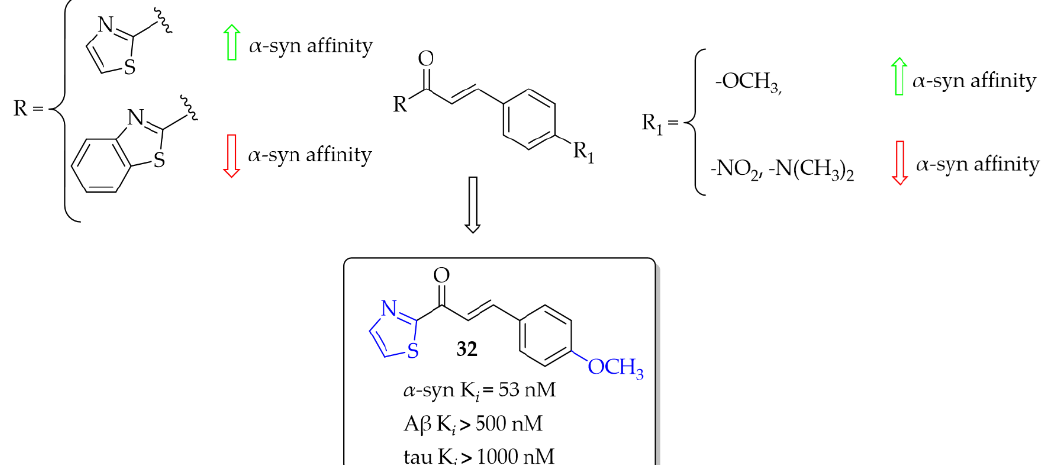
Figure 24. Chalcones with affinities for α -syn fibrils and the most active compound in the series [54]. Designing α -syn detection probes was also described by Kaide et al. [55]. This work was a continuation of previous work in this field [56]. Now, a series of chalcones with different aryl groups in the ring A and 4-(dimethylamino)phenyl or 4-nitrophenyl (as the ring B ) were designed and synthesised. Next, binding affinity of compounds towards α -syn was evaluated in the ThT competitive binding assay. Then, in the same assay, binding affinity for A β was evaluated. In vitro studies showed that the aryl groups positively affected the affinity for inhibiting fibre aggregation of recombinant α -syn (K i ranging from 0.49 to 13 nM). Among the series with the 4-(dimethylamino)phenyl group, com- pound 33 (Figure 25) showed the highest affinity for α -syn (K i = 0.49 nM) but also the highest affinity for A β (K i = 1.1 nM). In the 4-nitrophenyl series, the most potent was compound 34 (Figure 25) with a K i of 0.52 nM. In this series, none of compounds showed affinity for A β aggregates. These results were also confirmed in human aggregates. 4- (Dimethylamino)phenyl derivatives visualised both α -syn and A β aggregates whereas, in the 4-nitrophenyl series compounds recognised only human α -syn aggregates. Thus, compound 34 , as the most promising, was chosen for 125 I labelling reaction and further studies (compound 35 ; Figure 25). In a saturation binding assay, compound 35 bound to α -syn aggregates with a high affinity (K d = 6.9 nM) and maximum of binding sites (B max ) of 9.5 pmol/nmol protein, whereas for A β aggregates K d it was 102 nM and B max was 57.6 nM, respectively. Pharmacokinetic studies in vivo showed high stability in murine plasma and moderate uptake in the mouse brain. Thus, compound 35 is a promising lead structure in the search for radio-labelled tracers for imaging α - syn inclusions